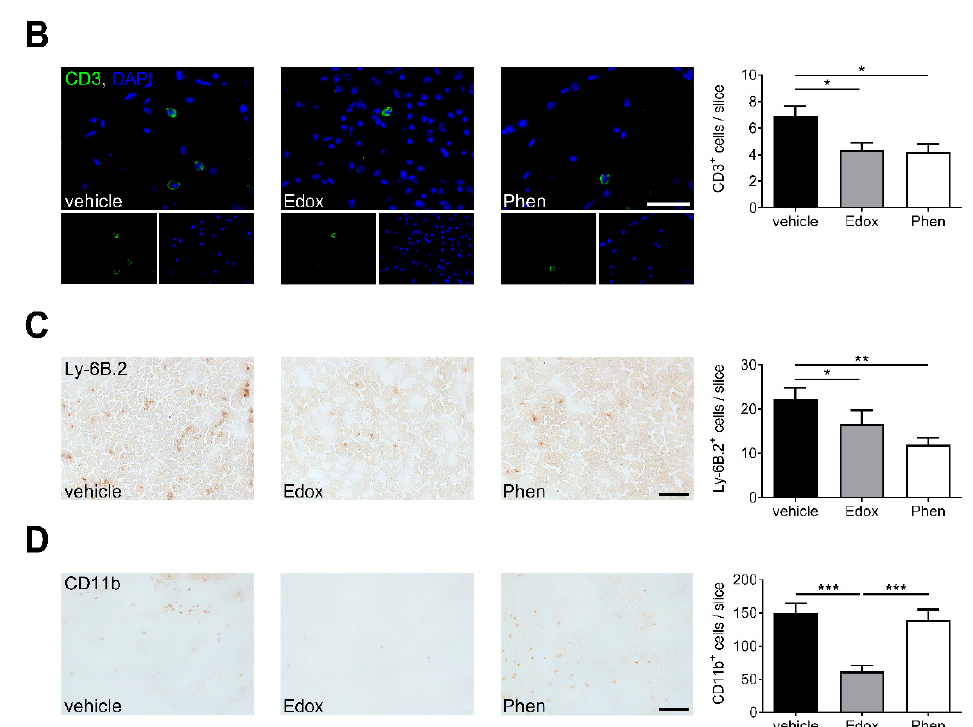
Figure 3. Edoxaban exerts anti-inflammatory effects in ischemic stroke. ( A ) Relative gene expression of tumor necrosis factor alpha (TNF α ), interleukin-1 β (IL-1 β ) and interleukin-6 (IL-6) in the ischemic cortices ( top ) and basal ganglia ( bottom ) of vehicle-, edoxaban (Edox)-, or phenprocoumon (Phen)-treated mice 24 h after transient middle cerebral artery occlusion (tMCAO) ( n = 7–10). ( B ) Left : Representative immunohistochemical staining of CD3 + T cells (green) and nuclei (blue) in the ischemic hemisphere of vehicle-, edoxaban-, or phenprocoumon-treated mice 24 h after tMCAO (scale bar = 50 µ m). Right : Quantification of CD3 + T cells per slice in the infarcted hemispheres at day 1 after tMCAO ( n = 5). ( C , D ) Left : Representative immunocytochemical staining of Ly-6B.2 + neutrophils ( C ) and CD11b + macrophages/microglia ( D ) in the ischemic hemisphere of vehicle-, edoxaban-, or phenprocoumon-treated mice 24 h after tMCAO (scale bar = 100 µm). Right : Quantification of Ly6B.2 + neutrophils and CD11b + macrophages/microglia per slice in the infarcted hemispheres at day 1 after tMCAO ( n = 5). * p < 0.05, ** p < 0.01, *** p < 0.001.